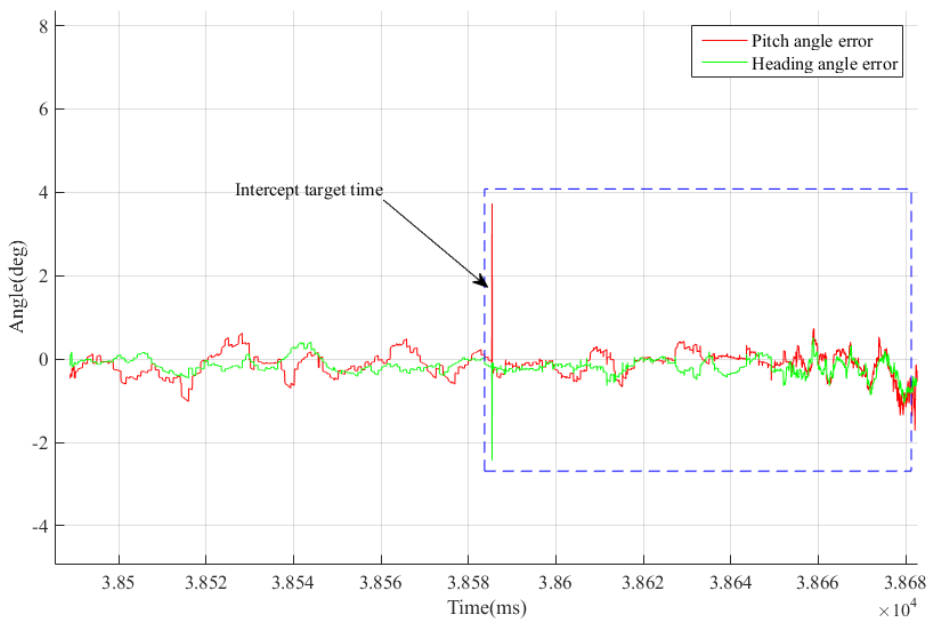
Figure 20. Intrinsic errors of the radar guidance